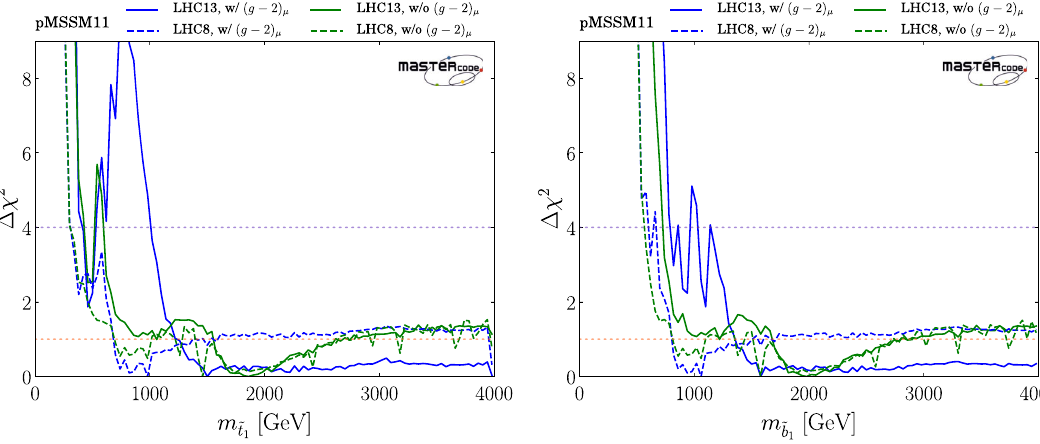
Fig. 9 Left panel: One-dimensional profile likelihood functions for the ˜ t 1 mass in the pMSSM11 with (blue) and without the ( g − 2 ) μ constraint (green) and with (solid) and without (dashed) applying the constraints from LHC Run II. Right panel: Similarly for the ˜ b 1 mass